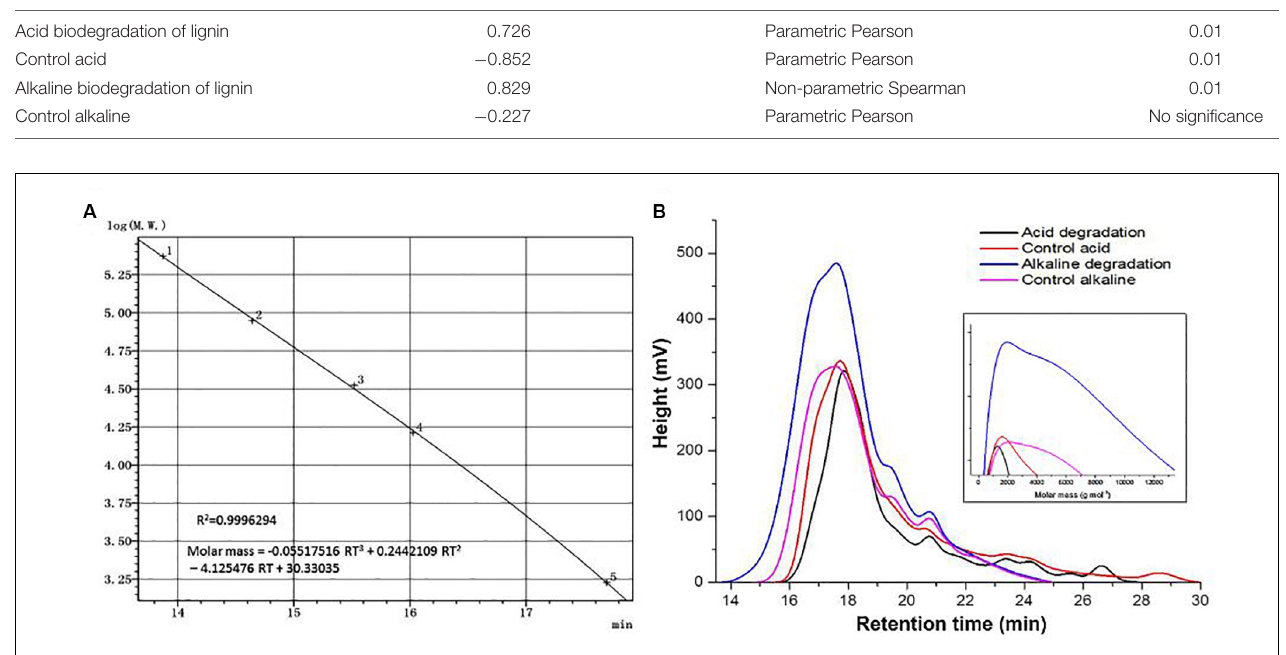
TABLE 2 | Statistical correlation between optical density and pH for acid and alkaline biodegradation of lignin and controls.